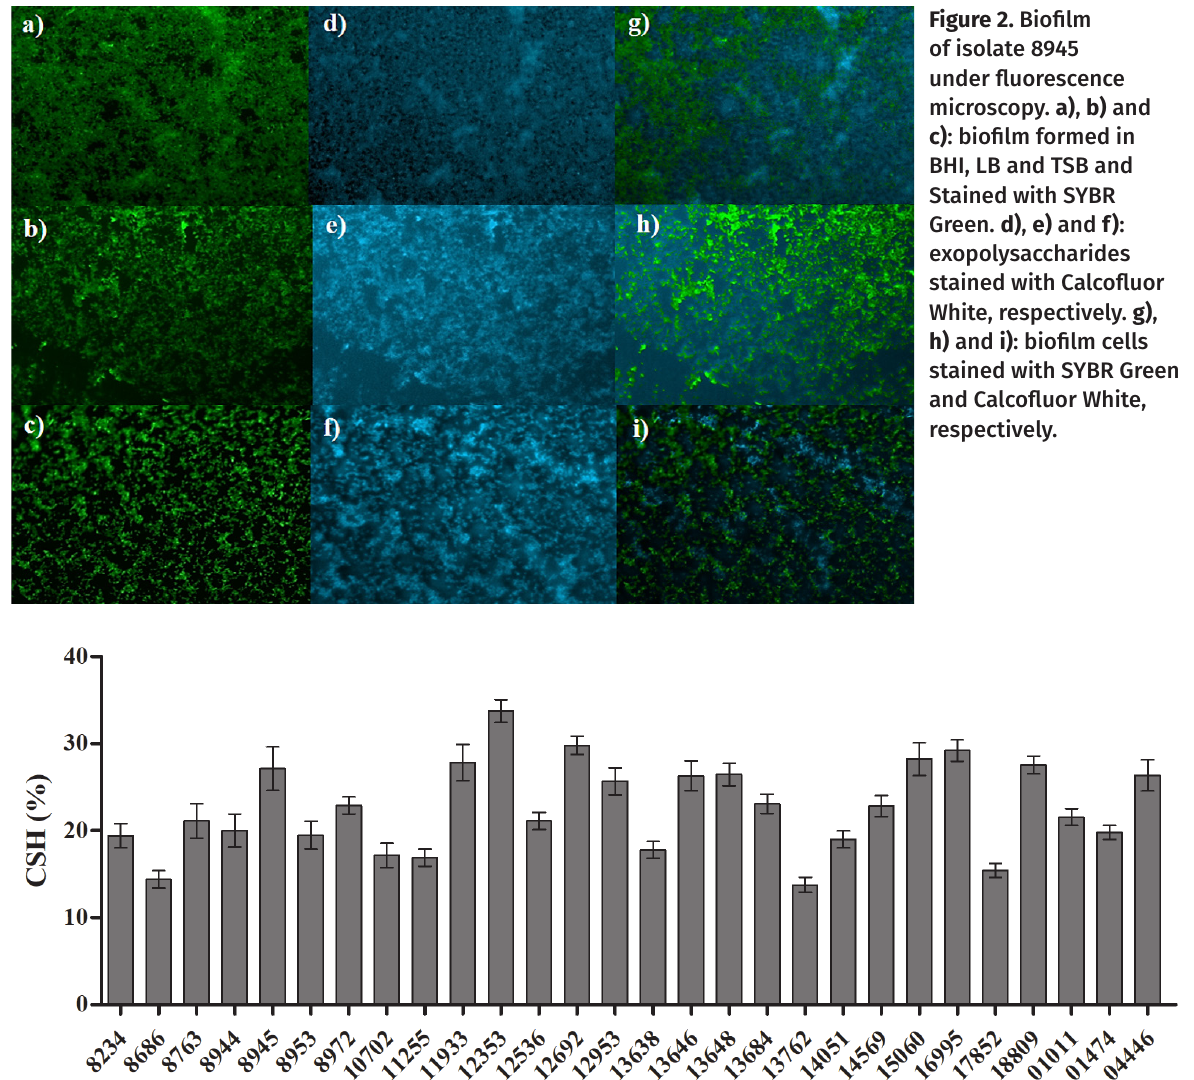
Figure 3. Percentage of the cell surface hydrophobicity (CSH) profile of P. stuartii isolates, represented by the mean of three bacterial suspensions in p-xylene (1: